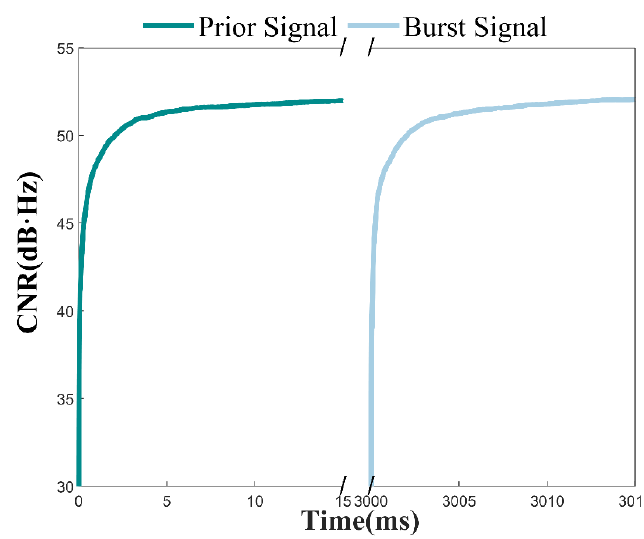
Figure 4. The convergence of the traditional algorithm.